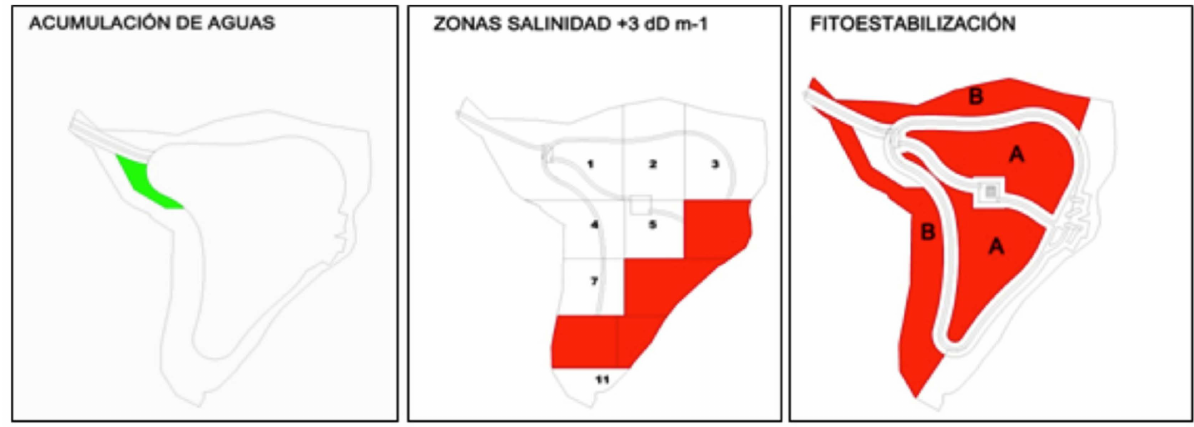
Figure A2. General view of castle and engine room in Case Study 1.